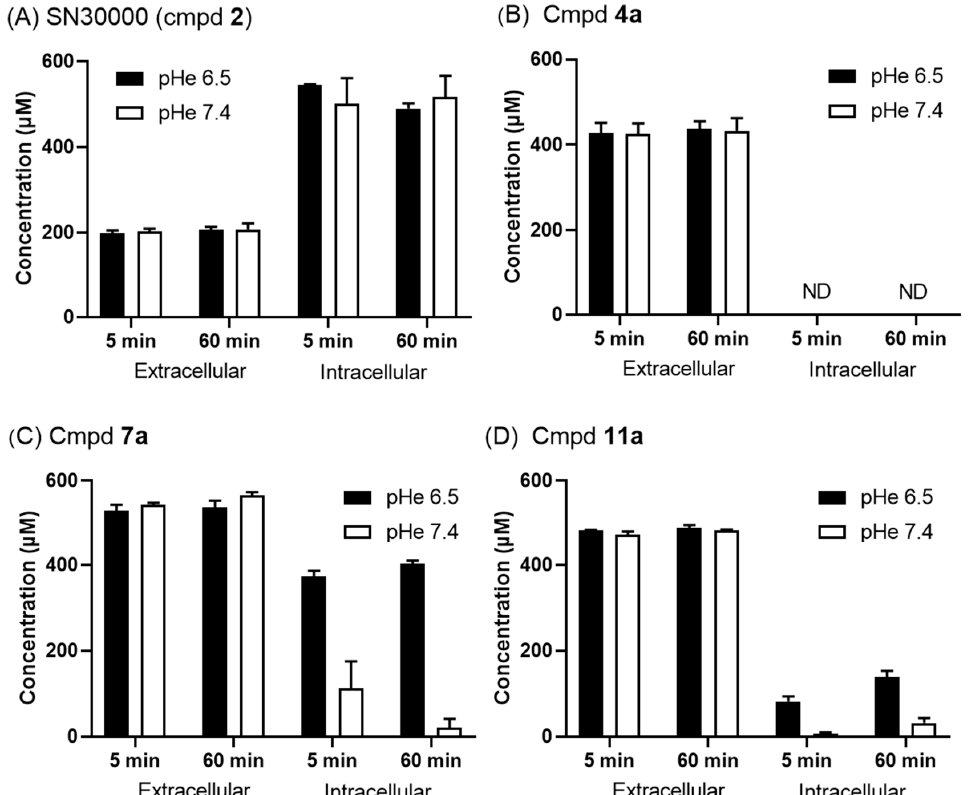
Figure 4. Cellular uptake of SN30000 ( A ) and BTO acids 4a ( B ), 7a ( C ) and 11a ( D ) in stirred aerobic SiHa cell suspensions (2 × 10 6 cells / mL). Nominal initial concentrations were 200 µ M for SN30000 ( 2 ) and 500 µ M for the other compounds. Values are mean and SEM for 3 replicates. ND: Not detected.